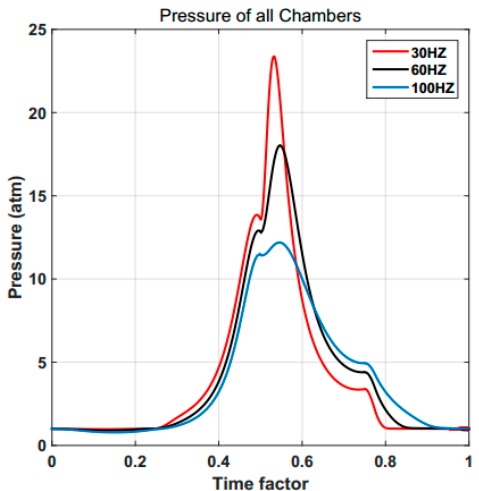
Figure 17. Changing process of pressure at different frequencies.